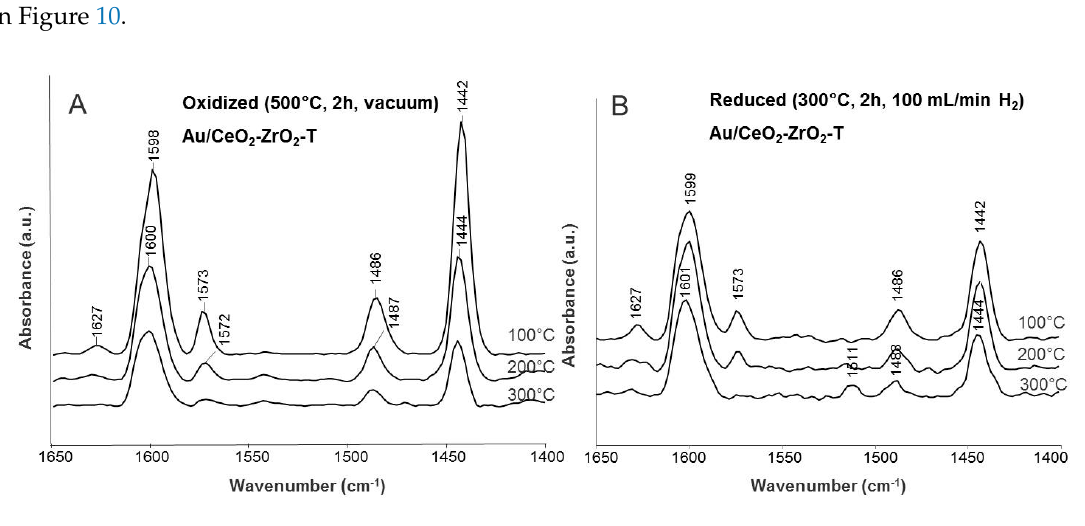
Figure 10. Difference spectra of adsorbed pyridine at 100, 200, and 300 °C for oxidized (A) and reduced (B) Au/CeO 2 -ZrO 2 -T sample.